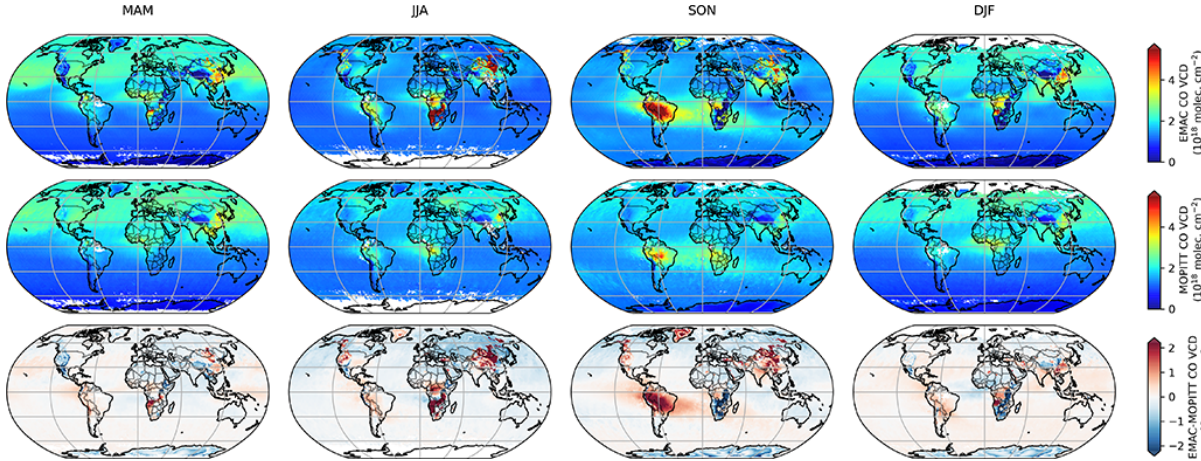
Figure 4. Global seasonal mean maps of CO vertical column densities (VCDs) for the year 2010 for EMAC (top), MOPITT (middle) and bias (EMAC − MOPITT)